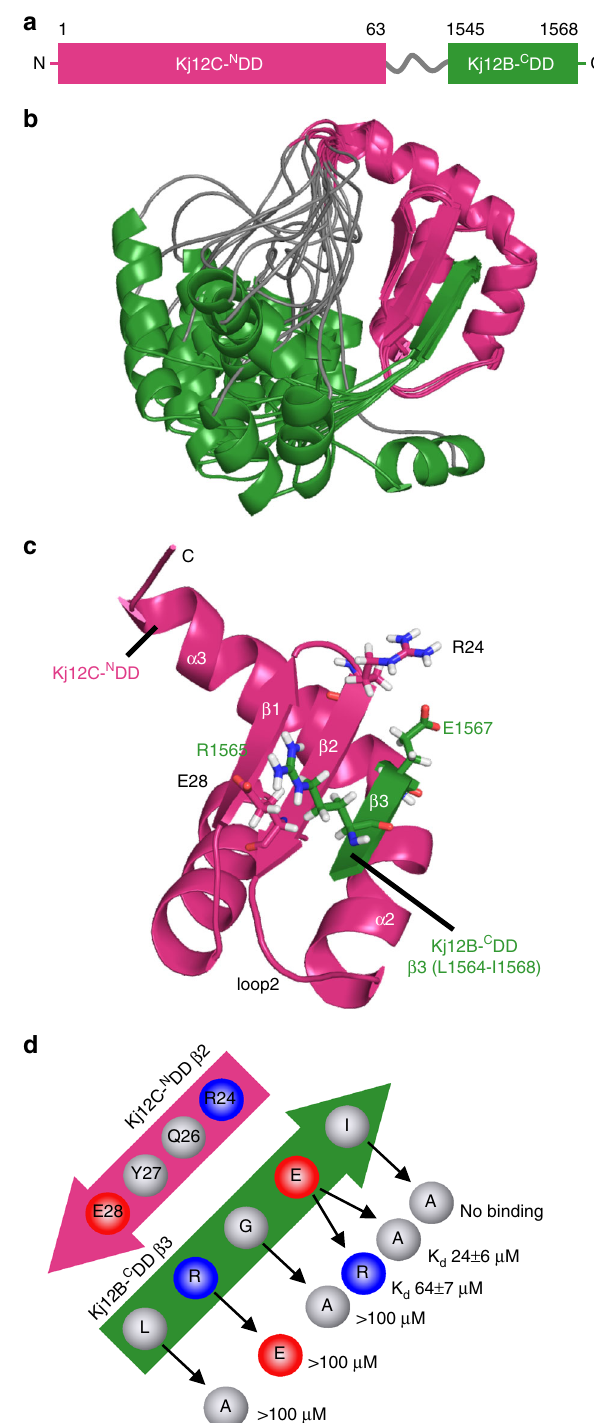
comprises only the β -sheet (eight C-terminal residues from Kj12B- C DD, aa 1561 – 1568, Fig. 3a). The end points of both NMR titration experiments (Kj12C- N DD with Kj12B- C DD and Kj12B- C DD short , respectively, in identical concentrations and ratios) overlapped perfectly (Supplementary Fig. 15) and ITC measure- ments con fi rmed that the short C DD peptide binds with a very similar af fi nity (15 ± 3 μ M) compared to the original longer C DD peptide (Supplementary Fig. 15).